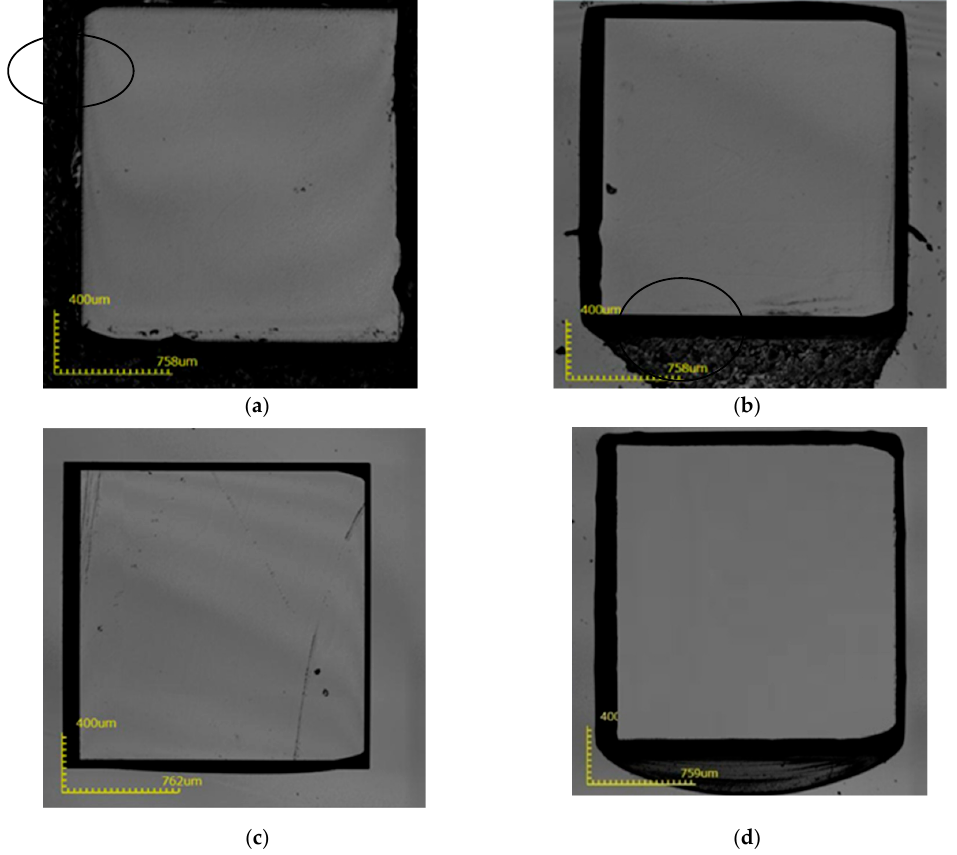
Figure 7. The surface state of the substrate after removing the mask layer after etching at 300 °C